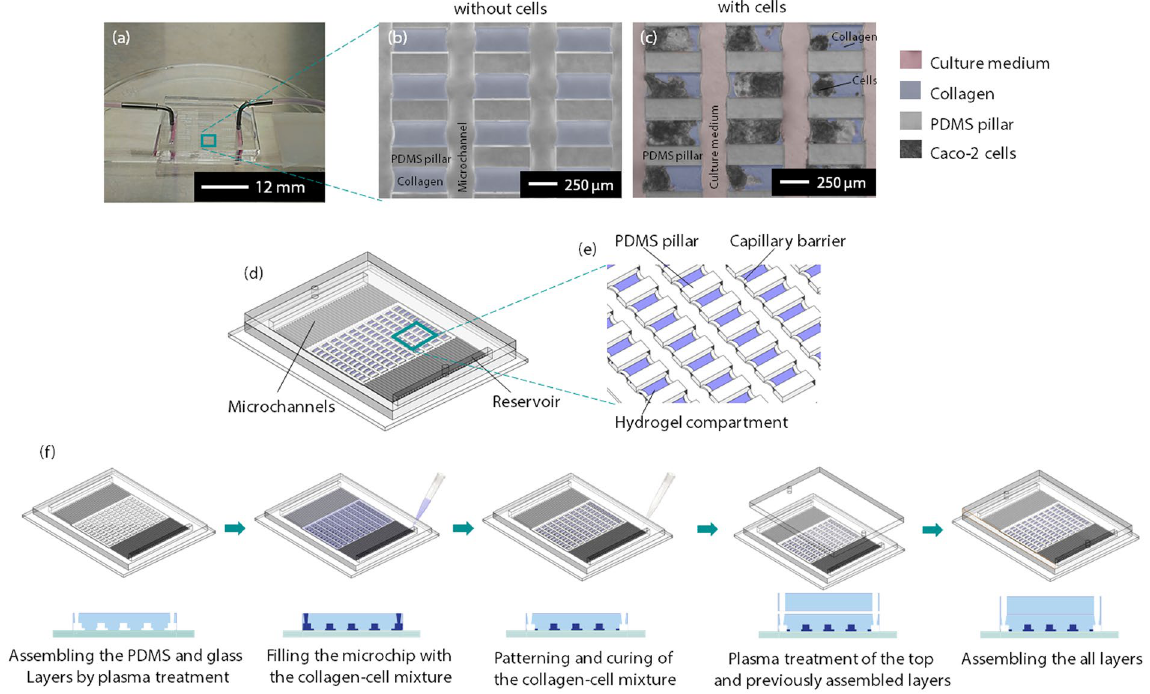
Figure 1. Overview of microfluidic chip design and the method of patterning hydrogels by capillary pinning. ( a ) A photograph of the microchip with attached tubing. ( b ) A zoomed in optical microscopy image of the PDMS pillar array (grey), hydrogel compartments (blue structures between glass pillars). ( c ) The pillar array with Caco-2 cells (on culture day 8), and culture media filled channels (pink). Microchannels and hydrogel compartments were pseudo-colored based on grey-scale differences. ( d ) Schematic isometric view of the microchip with hydrogel patterns. ( e ) A zoomed-in schematic illustration of the capillary barriers, PDMS pillars, and hydrogel compartments. The height of capillary barriers is 1/4 of the microchannel height. ( f ) Sequential steps of chip assembly and hydrogel patterning. The microchip was fabricated using standard soft lithography